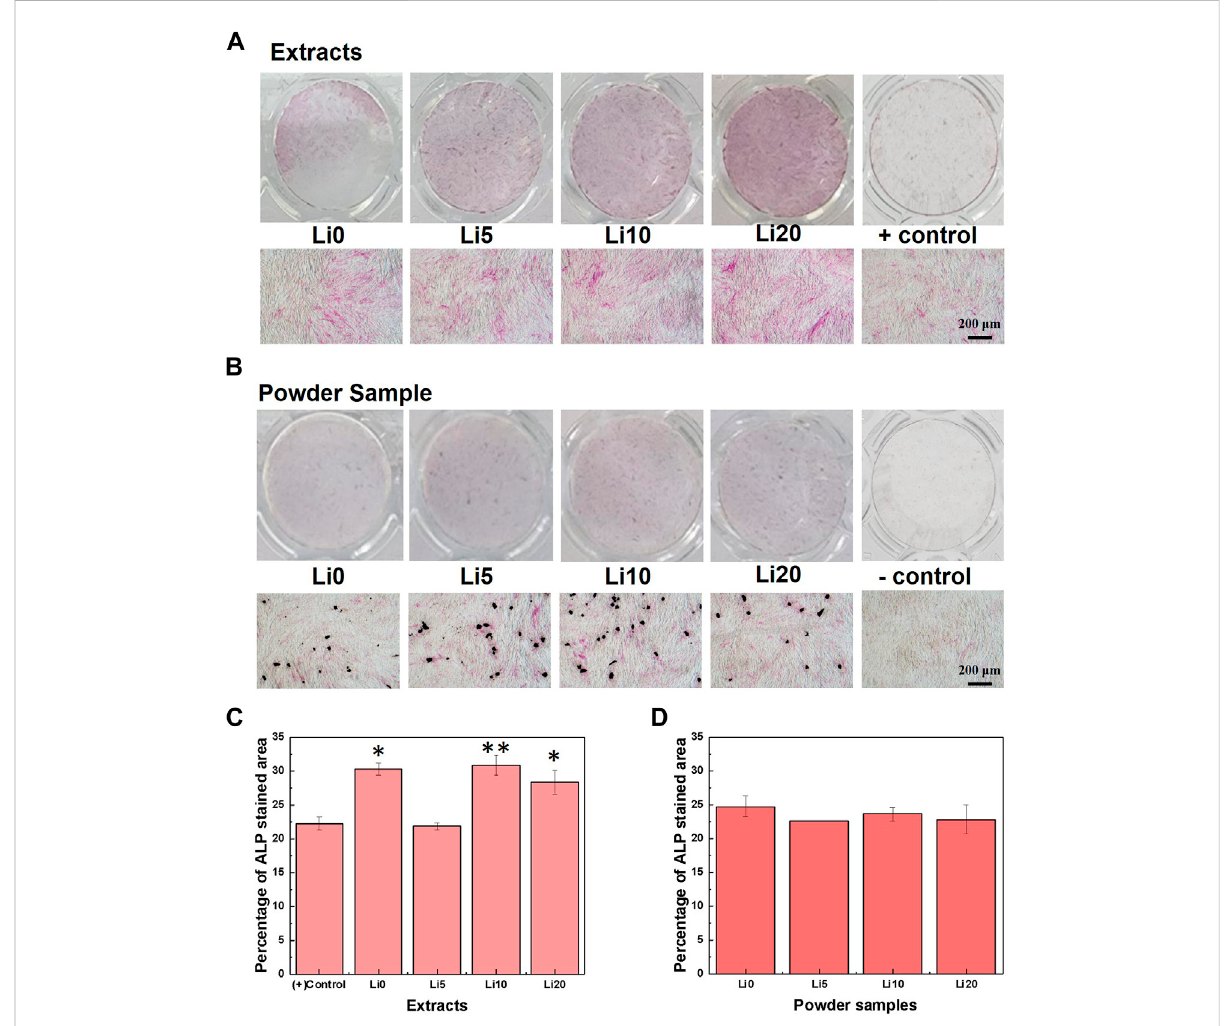
FIGURE 9 ALP staining results after 7 days; (A) 0.1 g/ml extracted samples and (B) 1mg/well powder samples, respectively, and quanti fi ed results of (C) 0.1 g/ml extracted samples and (D) 1mg/well powder samples. Asterisks indicate statistical signi fi cance (* p < 0.05 and ** p < 0.01) with respect to positive control as determined by independent t